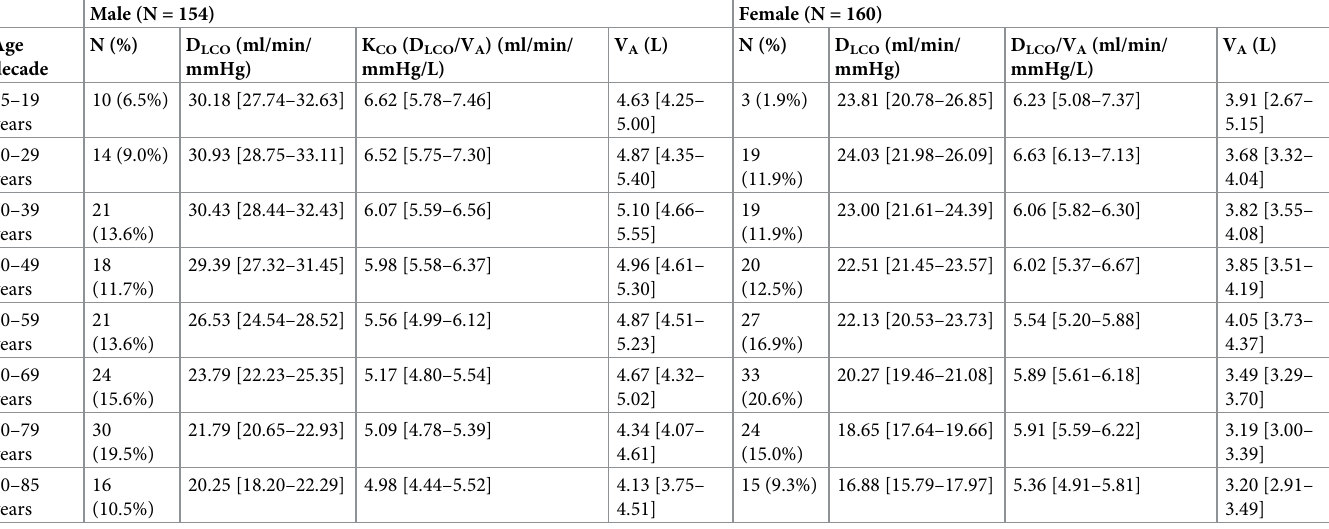
Table 2. Age distribution of study participants for the model assessment with mean and 95% confidence intervals for D LCO and D LCO /V A stratified by their sex. Male (N = 154)